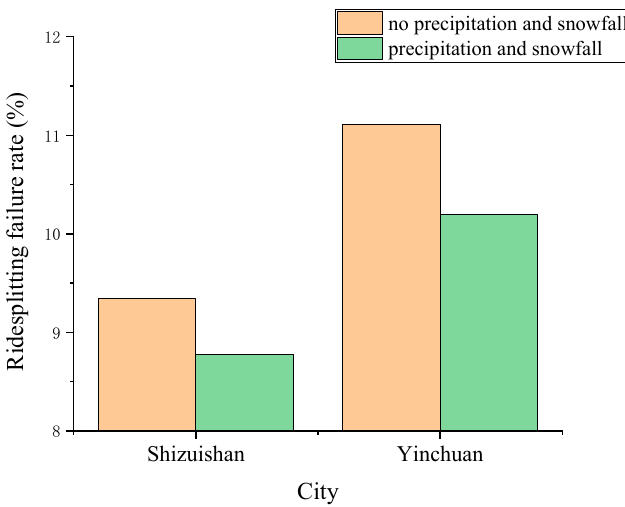
Figure 10. The intercity ridesplitting failure rate under different weather conditions.